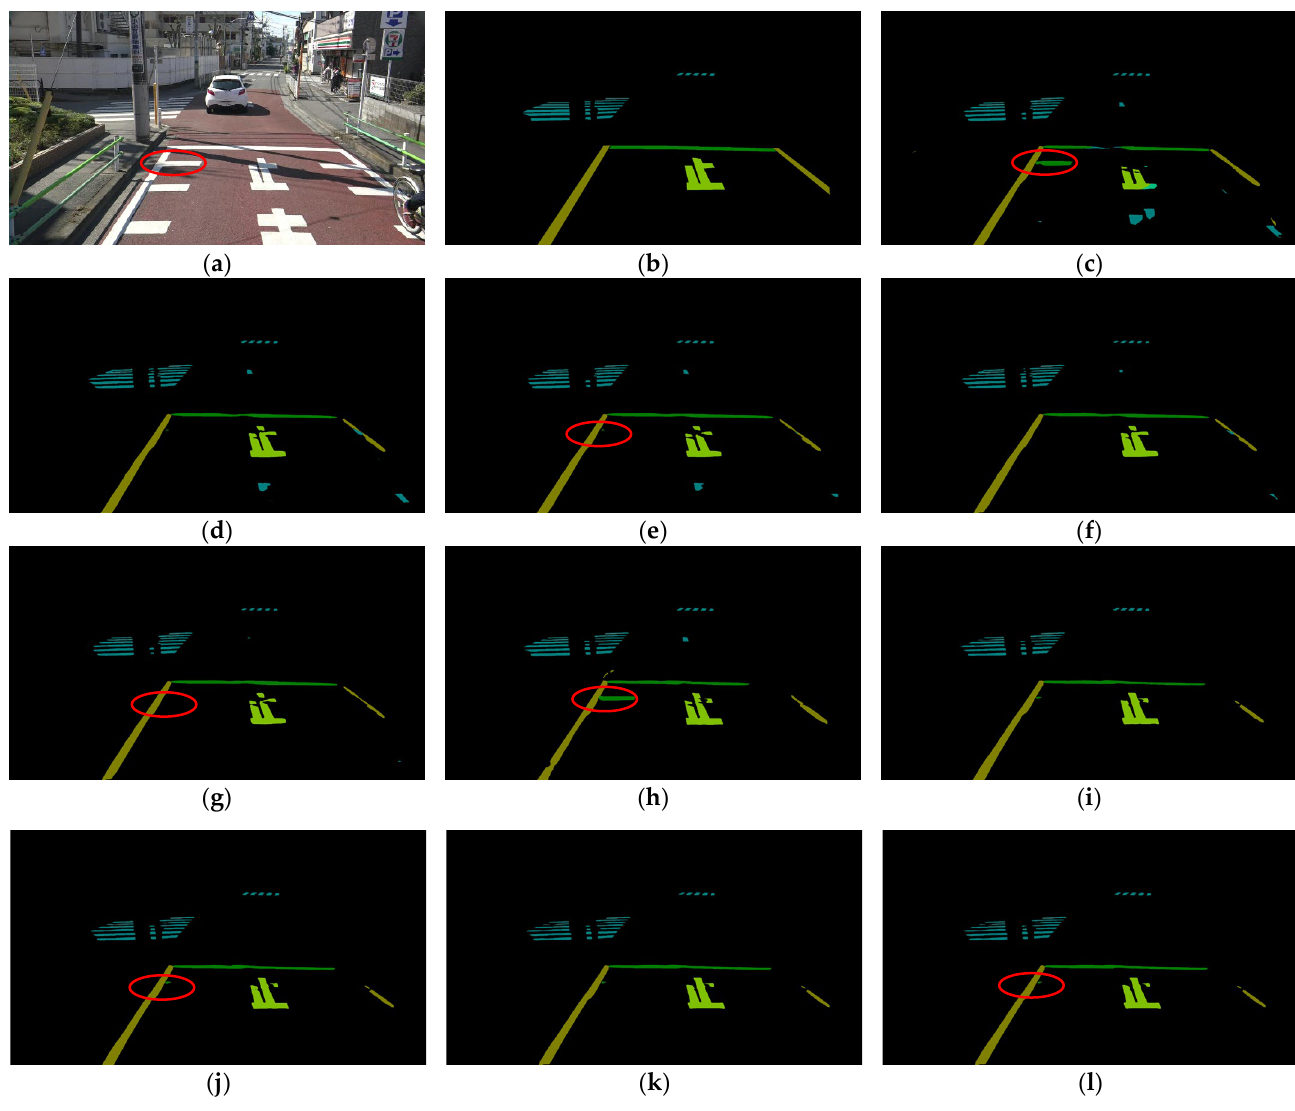
Figure 7. Examples of results obtained by Model 1 and Model 2 with five kinds of multiscale inputs: ( a ) original input image; ( b ) ground truth; ( c ) prediction result of Model 1 with scales = { 1.0,2.0 } ; ( d ) prediction result of Model 1 with scales = { 0.5,1.0 } ; ( e ) prediction result of Model 1 with scales = { 0.5,1.0,2.0 } ; ( f ) prediction result of Model 1 with scales = { 0.25,0.5,1.0 } ; ( g ) prediction result of Model 1 with scales = { 0.25,0.5,1.0,2.0 } ; ( h ) prediction result of Model 2 with scales = { 1.0,2.0 } ; ( i ) prediction result of Model 2 with scales = { 0.5,1.0 } ; ( j ) prediction result of Model 2 with scales = { 0.5,1.0,2.0 } ; ( k ) prediction result of Model 2 with scales = { 0.25,0.5,1.0 } ; ( l ) prediction result of Model 2 with scales = { 0.25,0.5,1.0,2.0 } . The performances of multiscale inputs with s = 2.0 on the short white line are highlighted by the red